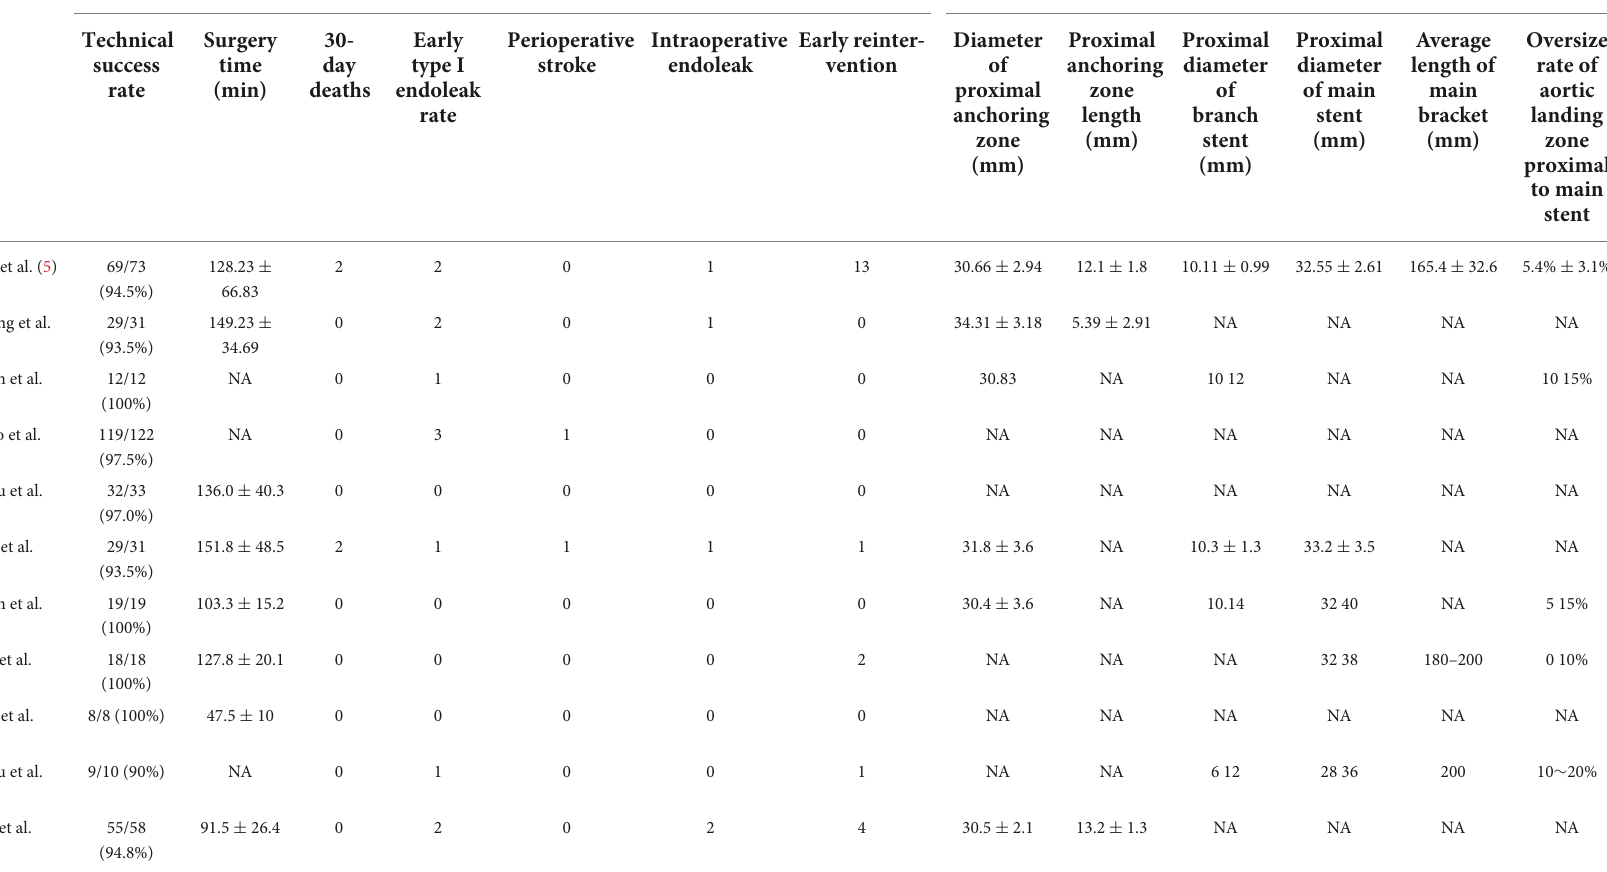
TABLE 2 Perioperative outcomes and details of the use of Castor branch